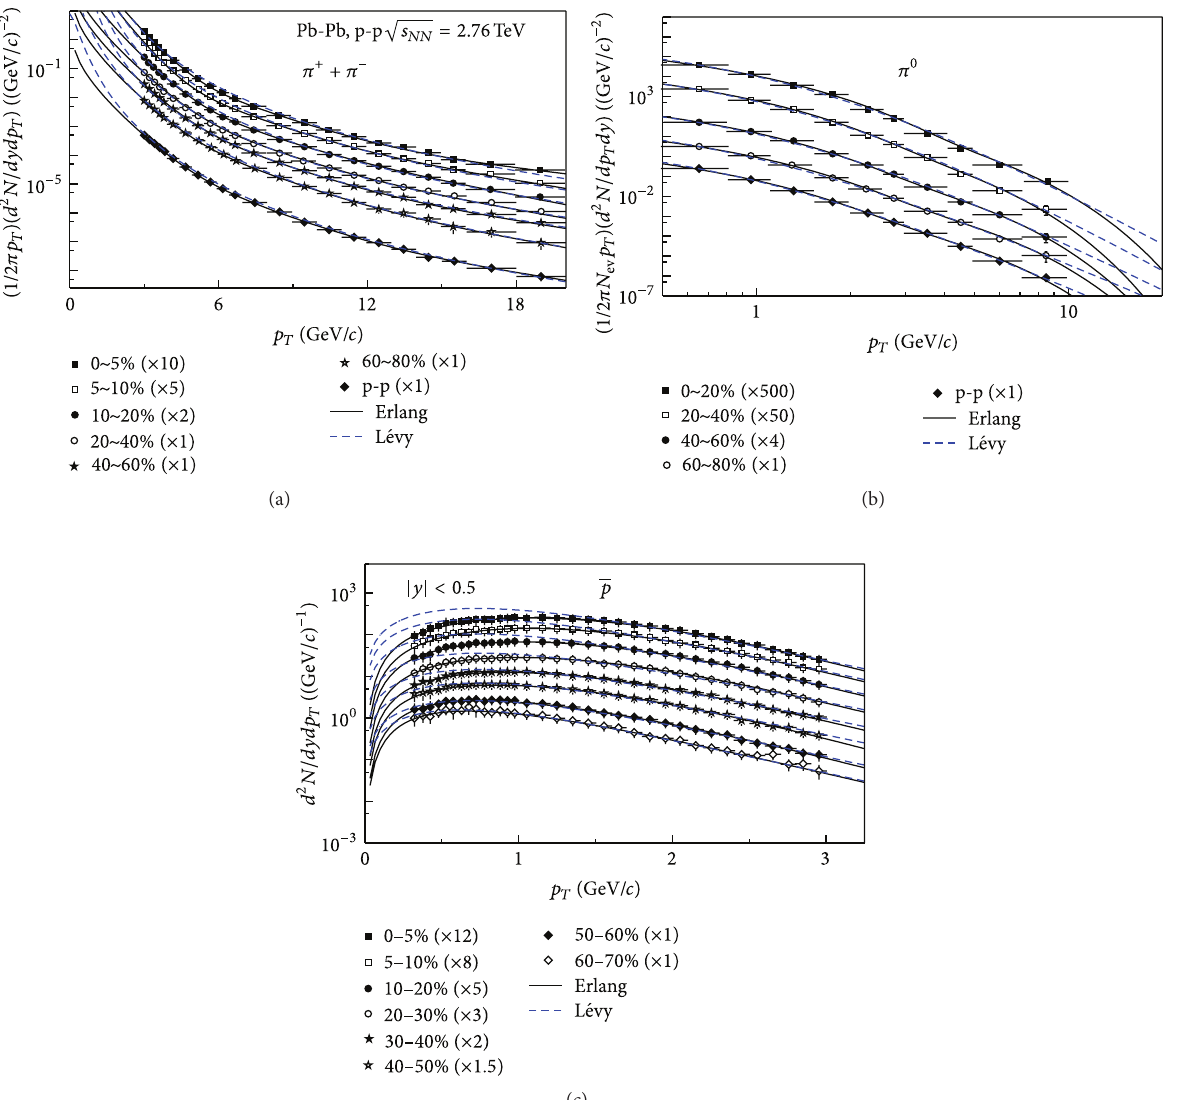
Figure 7: The 𝑝 𝑇 spectrums of (a) 𝜋 + + 𝜋 − , (b) 𝜋 0 , and (c) ̄𝑝 produced in √𝑠 𝑁𝑁 = 2.76 TeV Pb-Pb collisions in different centrality bins. For the sake of comparison, the results for 𝜋 + +𝜋 − and 𝜋 0 produced in 2.76 TeV p-p collisions are also given. The symbols represent experimental data of the ALICE Collaboration [16, 17]. The solid and dashed curves represent results calculated by the multicomponent Erlang distribution and the L´evy distribution,